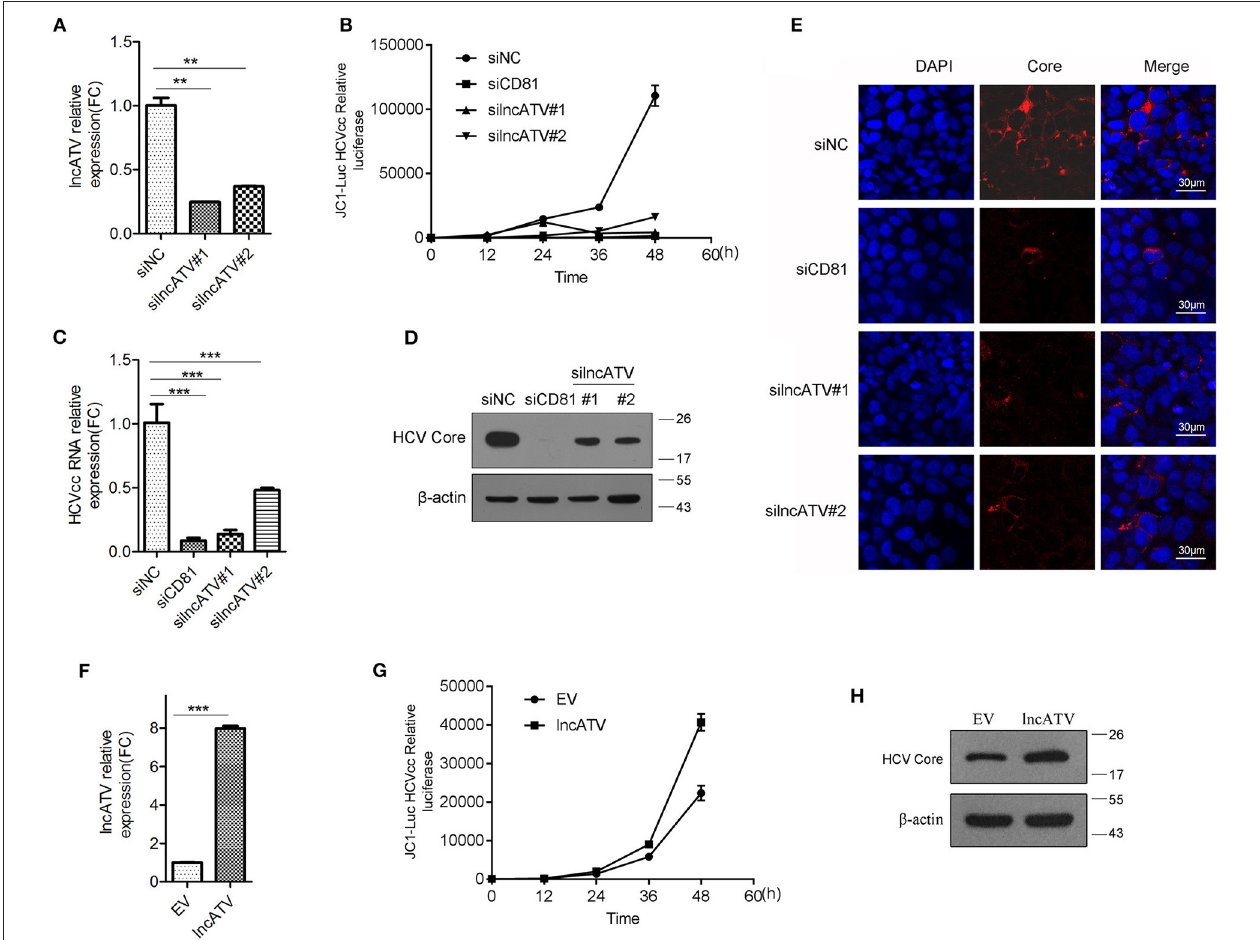
FIGURE 2 | LncATV promotes HCV infection. (A) Huh7 cells were transfected with negative control siRNA (siNC) or siRNAs targeting lncATV. Gene silencing effects were measured by qRT-PCR. (B) Huh7 cells were transfected with various siRNAs at 24h prior to Jc1-Luciferase reporter HCVcc infection. Luciferase activity was assayed at different timepoints post-infection. (C–E) As described in (B) except for the reporter HCVcc replaced by JFH-1 HCVcc. Intracellular HCV RNA (C) and viral core protein (D) were quantified by qRT-PCR with specific primers and Western blotting with indicated antibodies. Intracellular HCV core expression was detected by immunofluorescent staining (E) . Scale bars, 30 µ m. (F–H) Overexpression of lncATV exerts anti-HCV effect. Huh7 cells were transfected with lncATV expression plasmid or empty vector (EV) as a negative control at 24h prior to Jc1-Luciferase reporter HCVcc infection. At 72h or indicated timepoints post-infection, levels